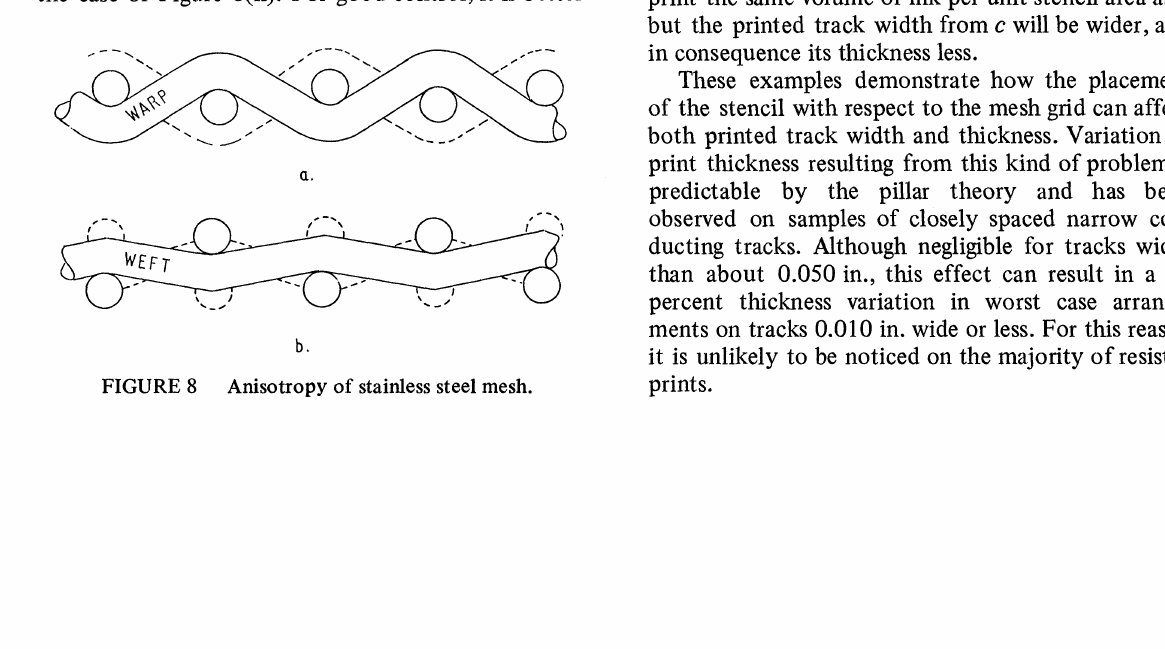
Anisotropy of stainless steel mesh.